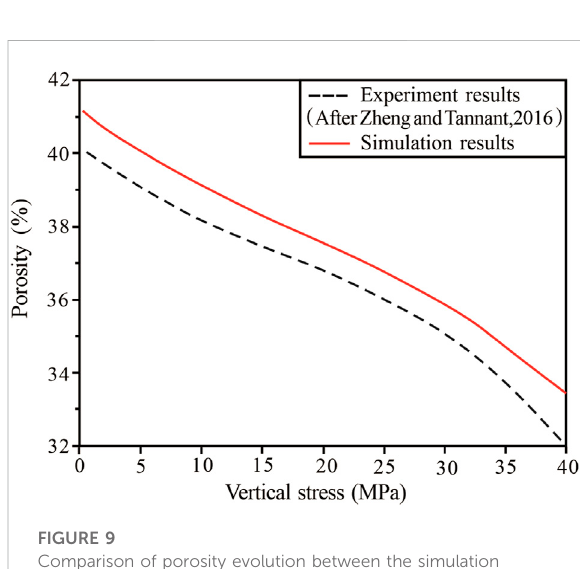
FIGURE 9 Comparison of porosity evolution between the simulation and